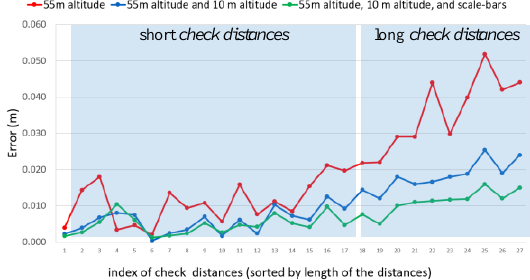
Figure 6 : Error on check distances. Short distances are the distances within small areas (captured also at 10 m altitude), and long distances means the distances between block